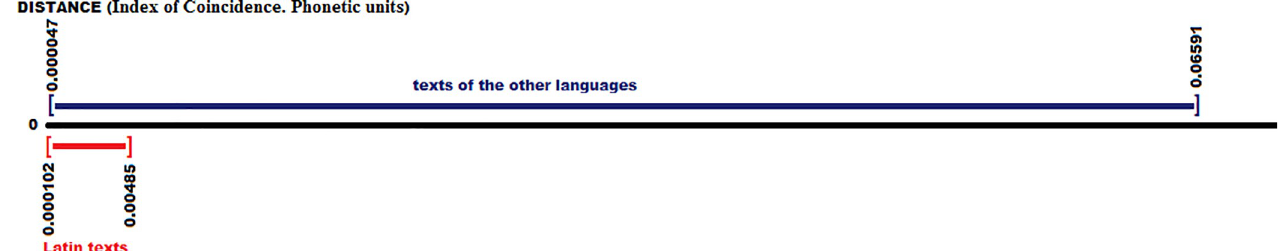
Fig 7. Index of Coincidence of the texts in Latin (phonetic units) (red color) versus the rest of the texts (blue color).